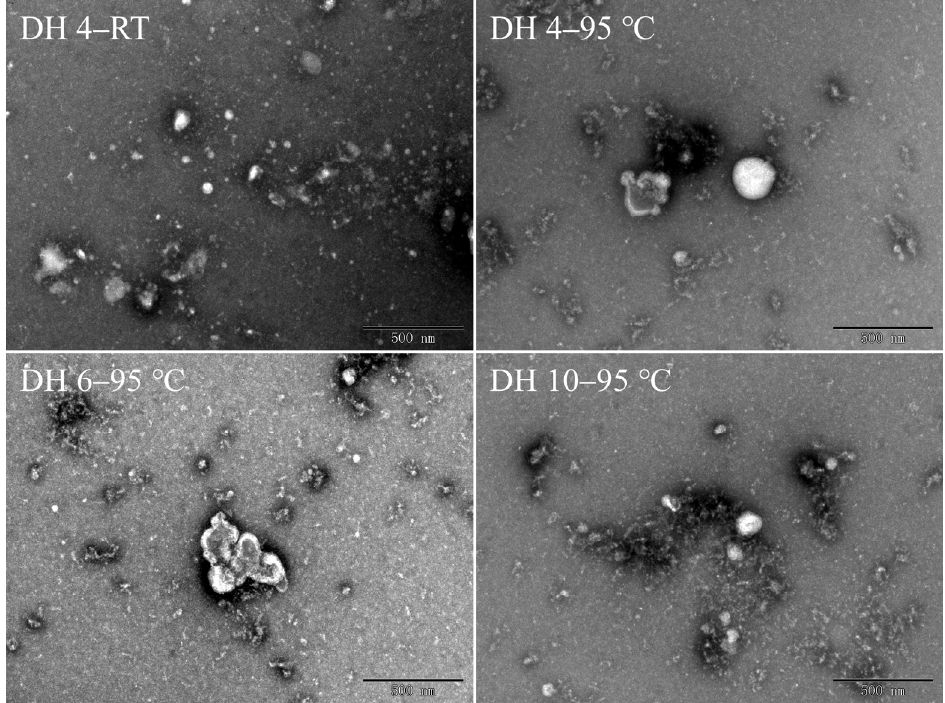
Figure 4. Transmission electron microscopy images of gluten polypeptides after heating for 120 min. DH 4, DH 6, and DH 10 represent the degree of hydrolysis 4.0%, degree of hydrolysis 6.0%, and degree of hydrolysis 10.0%, respectively.